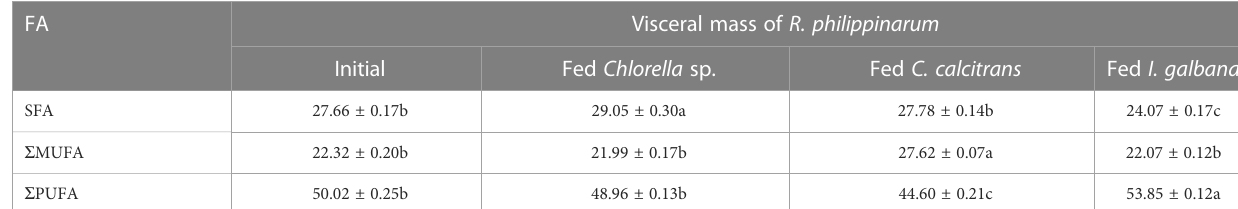
with I. galbana (Tables 1, 3). The levels of 20:3n-6 and ARA were signi fi cantly increased in R. philippinarum fed with Chlorella sp. and were signi fi cantly higher than those in fed with C. calcitrans and I. galbana (Table 1). For EPA, a signi fi cantly higher level was